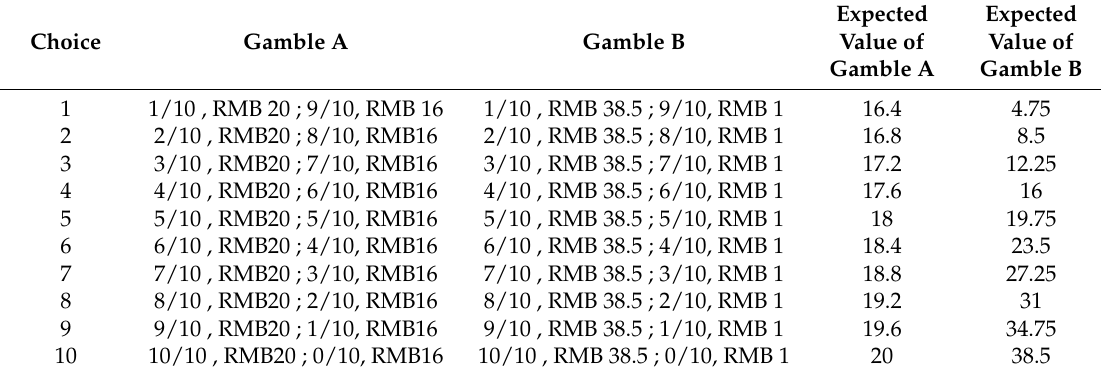
Table A1. The Gambles.